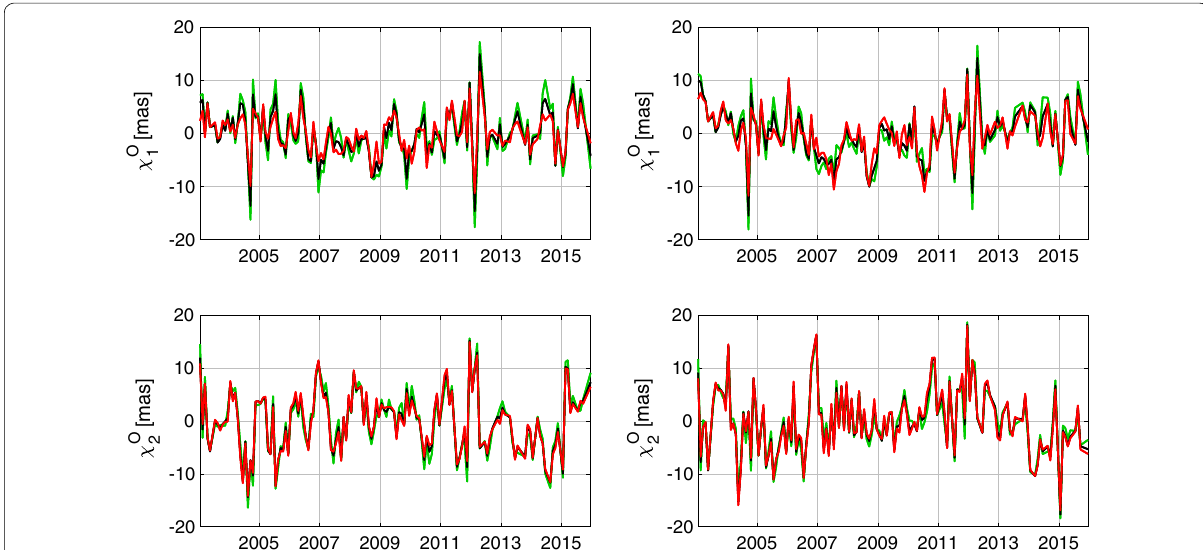
Fig. 9 Differences of the polar motion excitation functions for the oceans χ O derived from GRACE GFZ RL06 gravity field solutions by applying (1) only the DDK filter (green), (2) the DDK filter and the gain factors k (black) and (3) the DDK filter, the gain factors k and the scaling factors f i (red) with respect to the polar motion excitation functions derived from the ocean model ECCO (left) and from ESMGFZ data